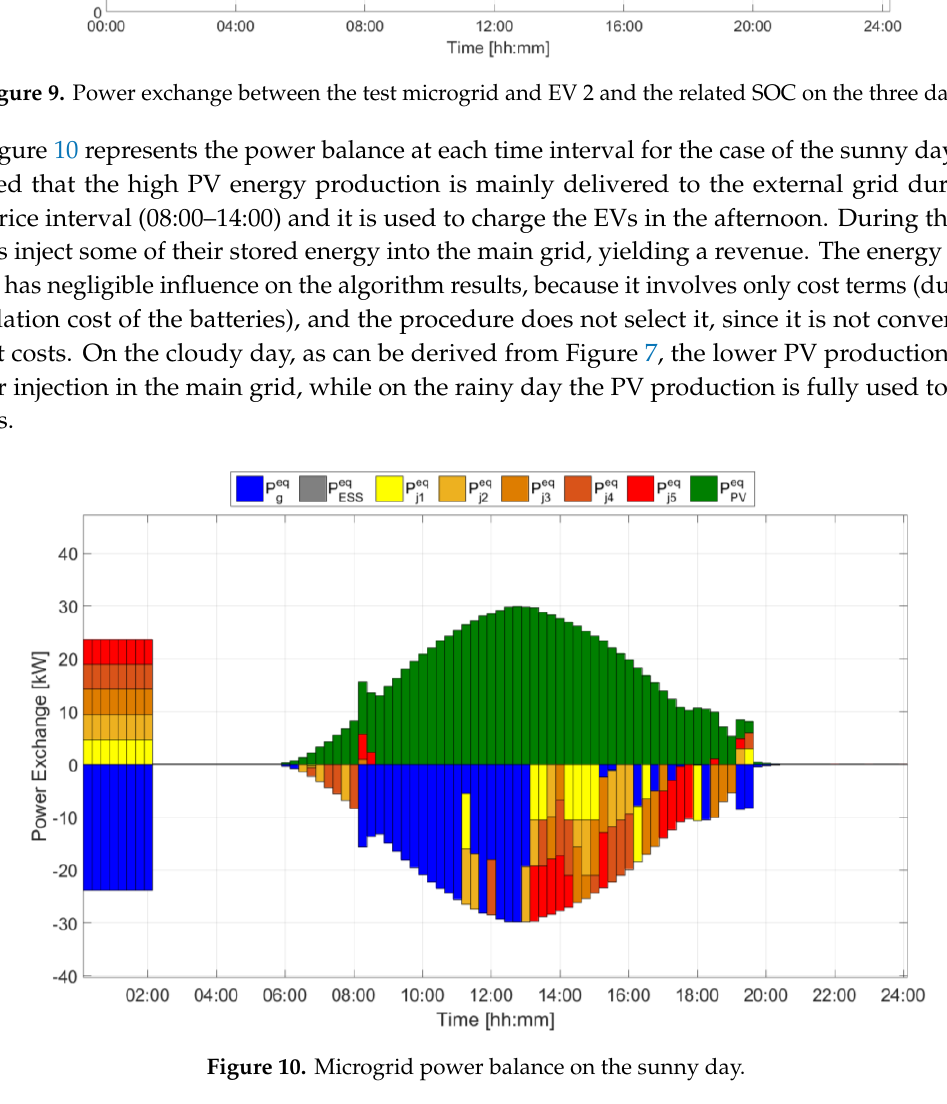
Figure 9. Power exchange between the test microgrid and EV 2 and the related SOC on the three days.